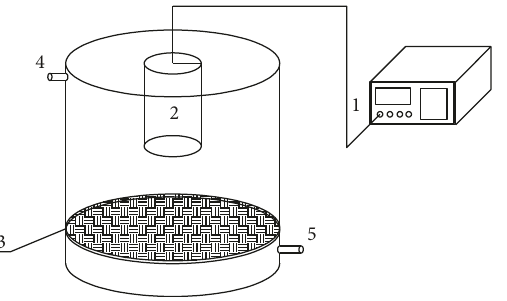
Figure 1: H S photodegradation reactor. (1) High-frequency 2 generator, (2) electrodeless VUV lamp, (3) gas distribution device, (4) gas outlet, and (5) gas inlet.